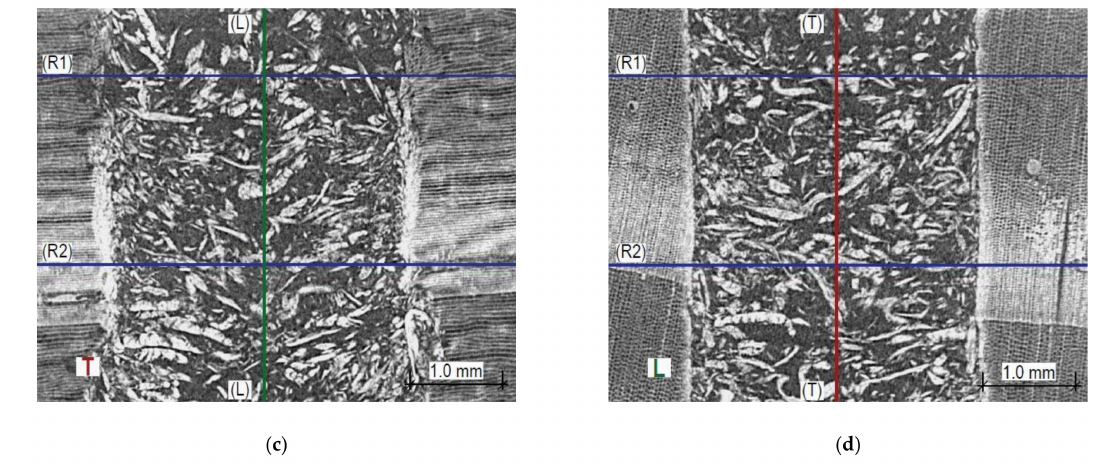
Figure 16. Sections through the opening after the resistance drilling test of the sample in the air-dry state. ( a ) Cross-section within earlywood R1—tangential wood surface visible; ( b ) Cross-section within latewood R2—tangential wood surface